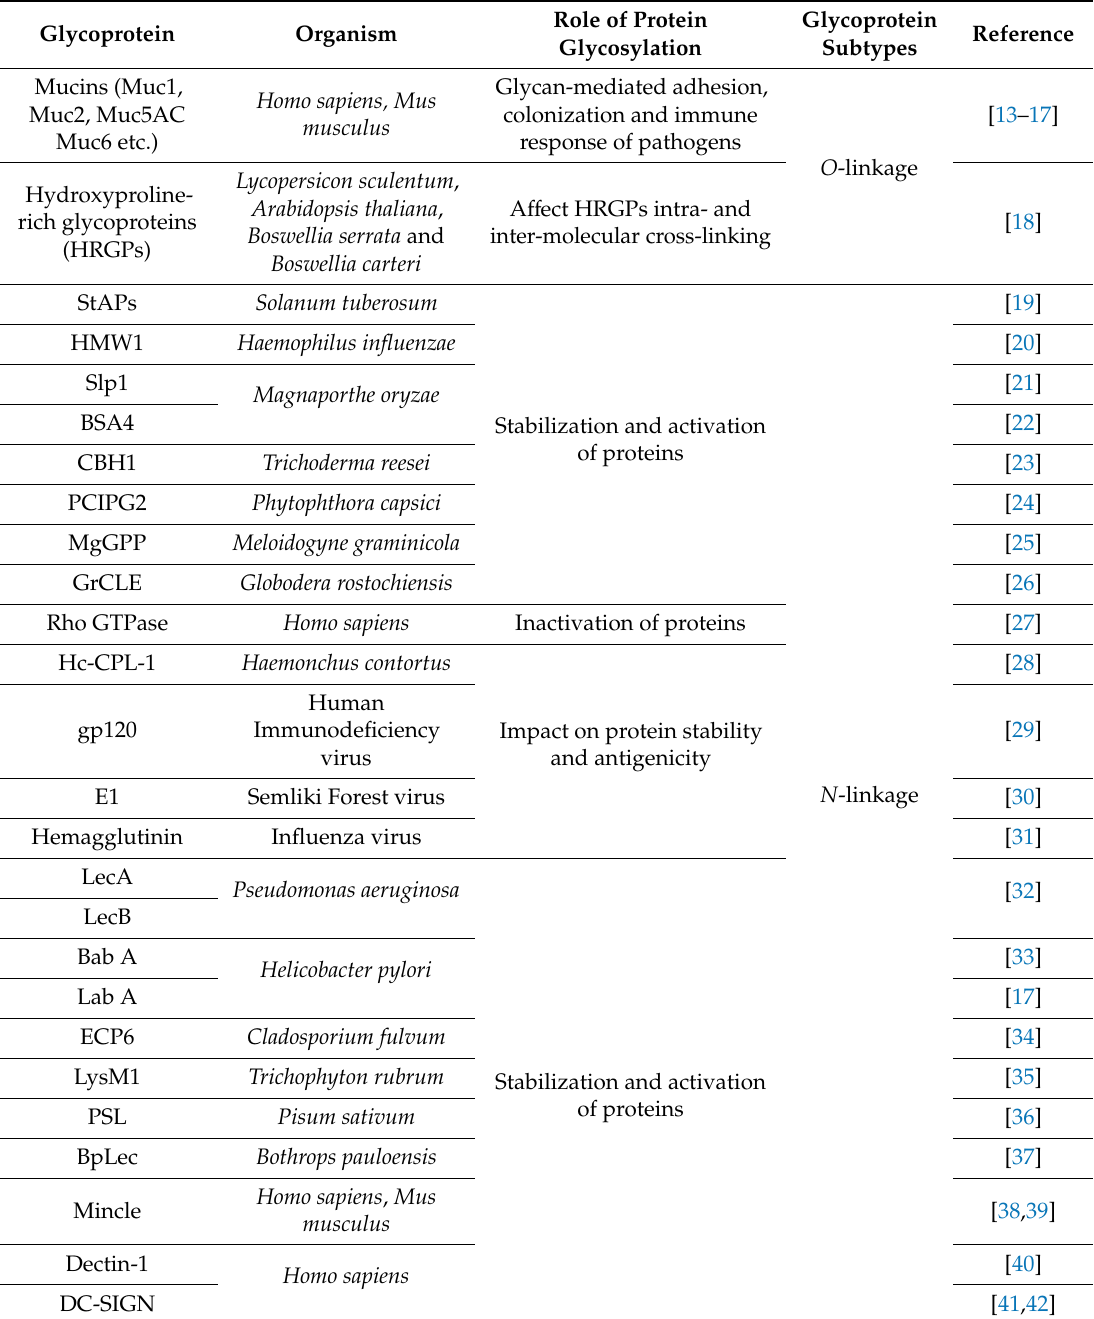
Table 1. Glycoproteins discussed in this